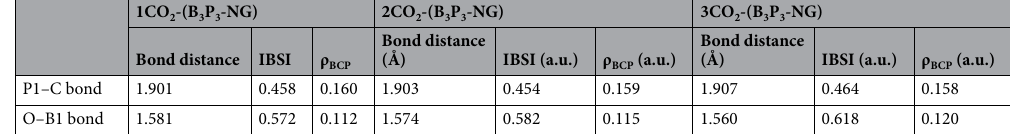
Table 2. Bond distances (Å), intrinsic bond strength index (IBSI) in a.u. and density at the Bond Critical Points (BCP) in a.u. of the P1-C and O-B1 bond in the different adducts. The IBSI were obtained using IGMPlot, and the BCP were localized with AIMAll at M06-2X/6-311+ +G(3df,3pd)//M06-2X/6-31+G* computational level.